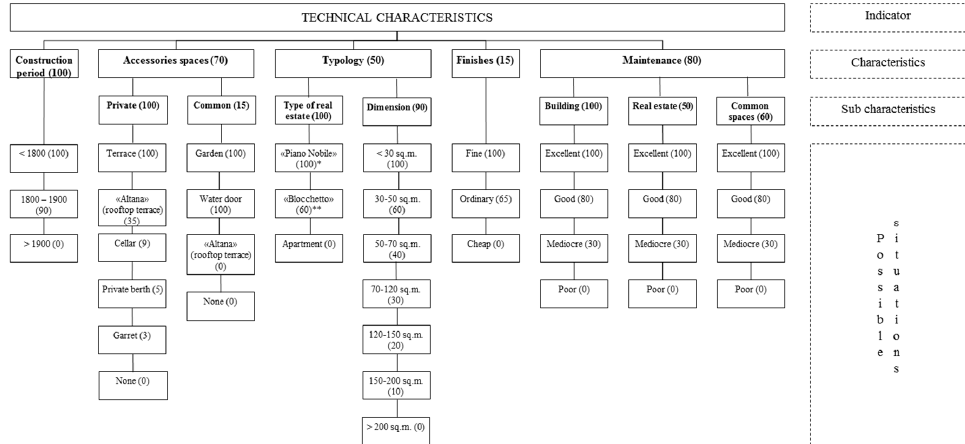
Figure 5. The structure of the “technical” indicator ( c t ) (* “Piano Nobile” is a property, usually located